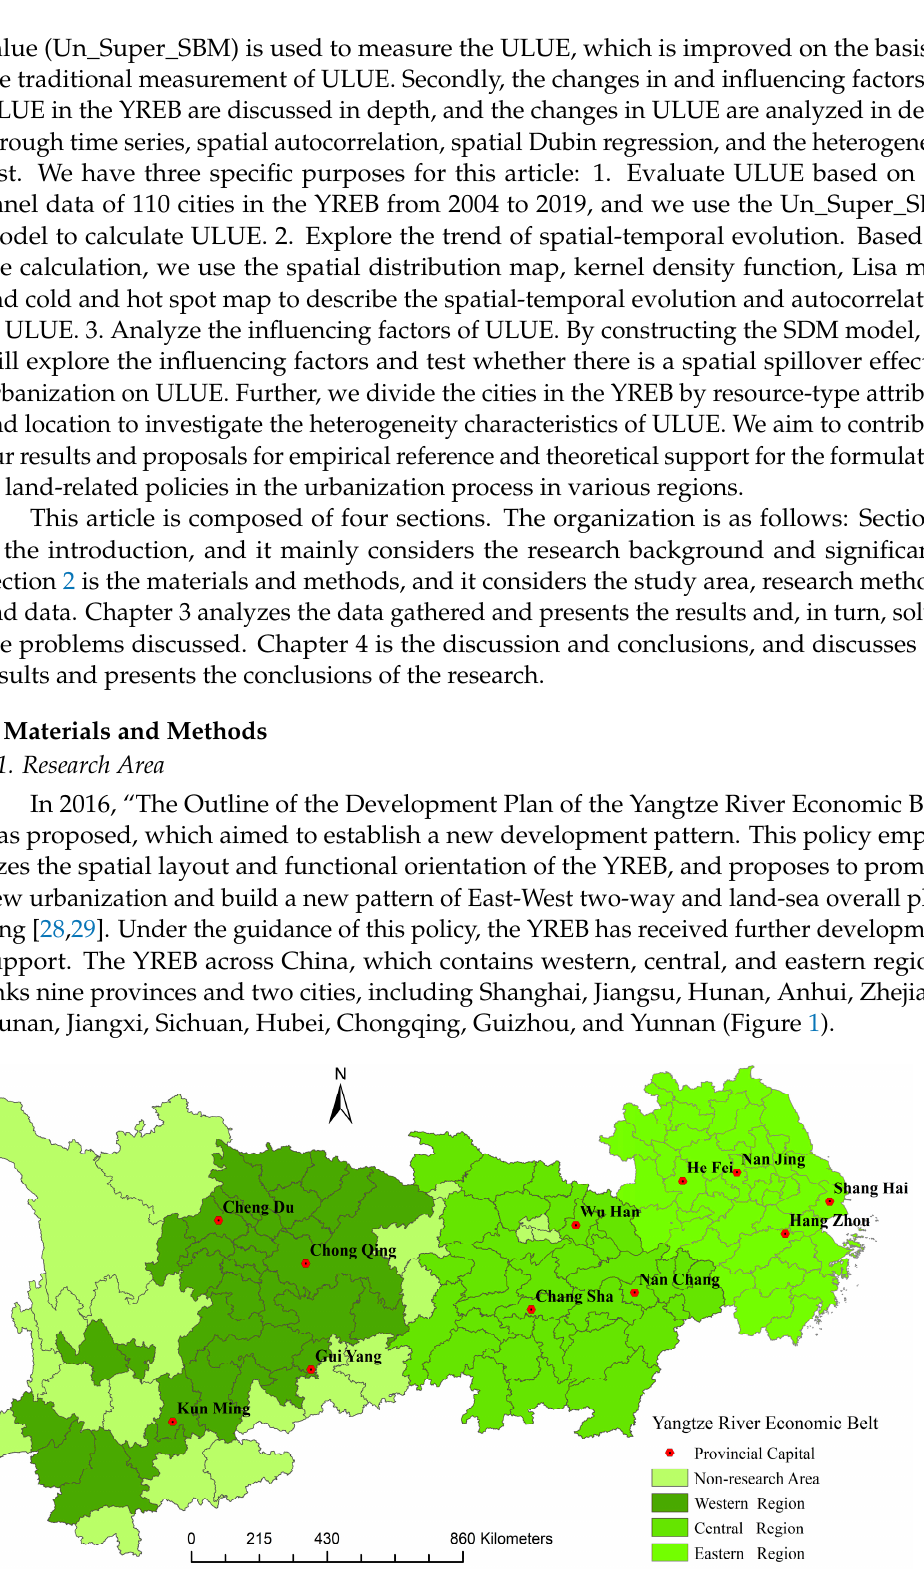
Figure 1. Regional map of the Yangtze river economic belt.